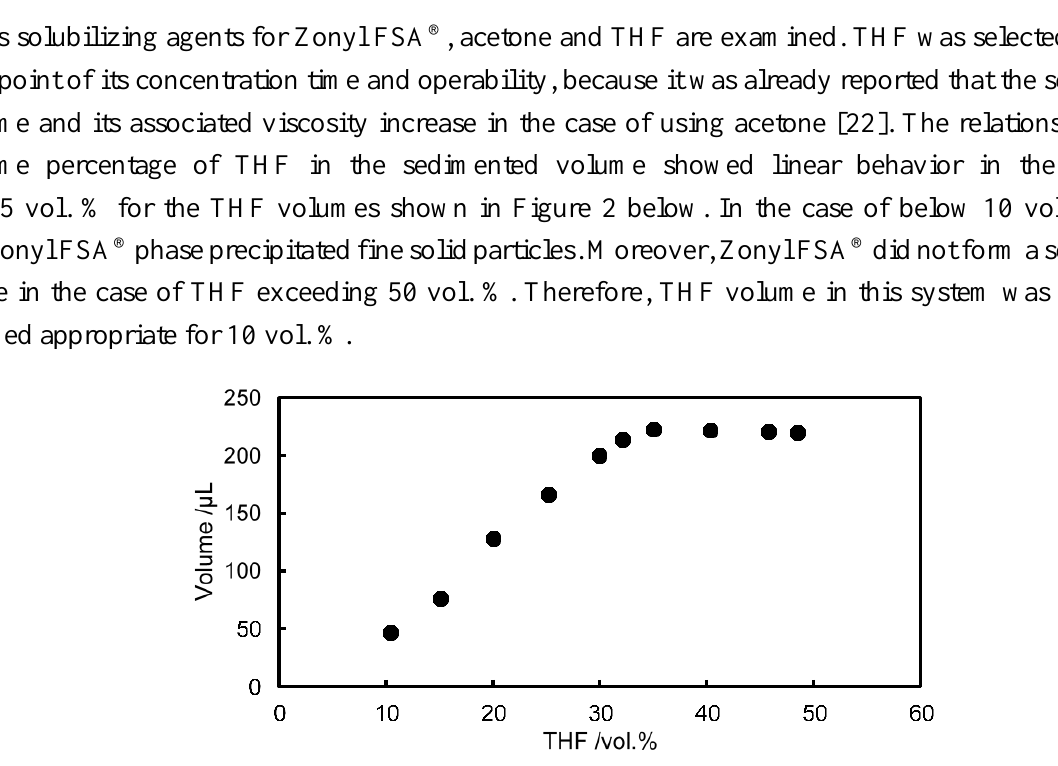
Figure 2. Relationship between the volume percentage of THF and the volume of sedimented phase. (Zonyl FSA ® ) = 10 vol. %; pH =